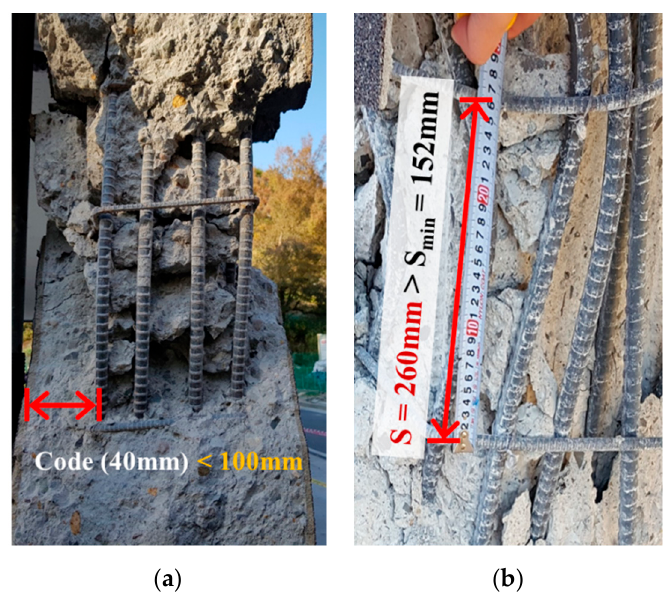
Figure 1. Structural damage due to inadequate construction after the Pohang Earthquake (2017): ( a ) excessive clear cover; ( b ) wide stirrup spacing (S is the observed spacing and S min is the minimum spacing specified by the design code).